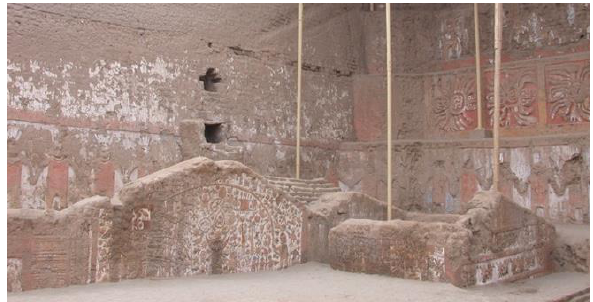
Figure 1. Huaca de la Luna,